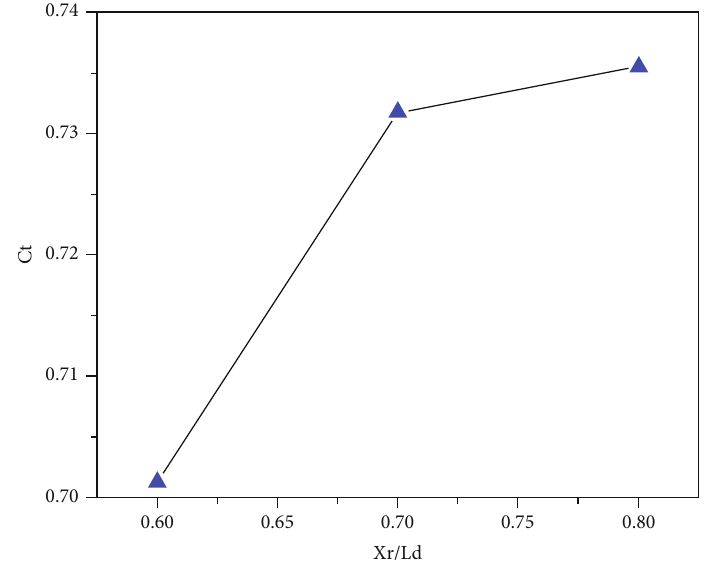
Figure 15: Thrust coe ffi cients for diverse rod locations (NPR =4.6 and H / R